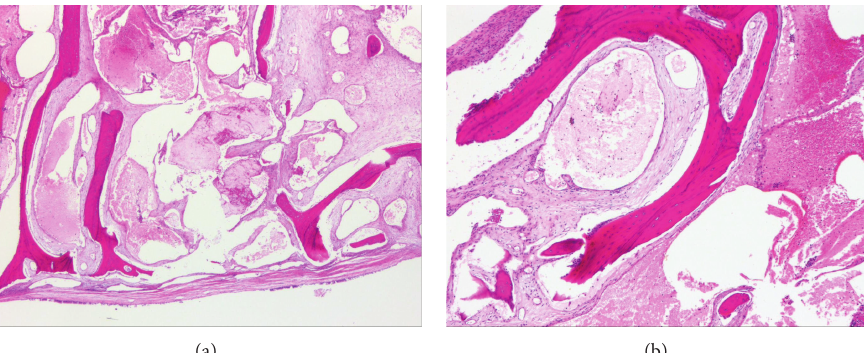
Figure 3: Postoperative histopathologic examinations showing blood-filled, thin-walled vessels between the bony trabeculae: (a) × 20; (b) ×